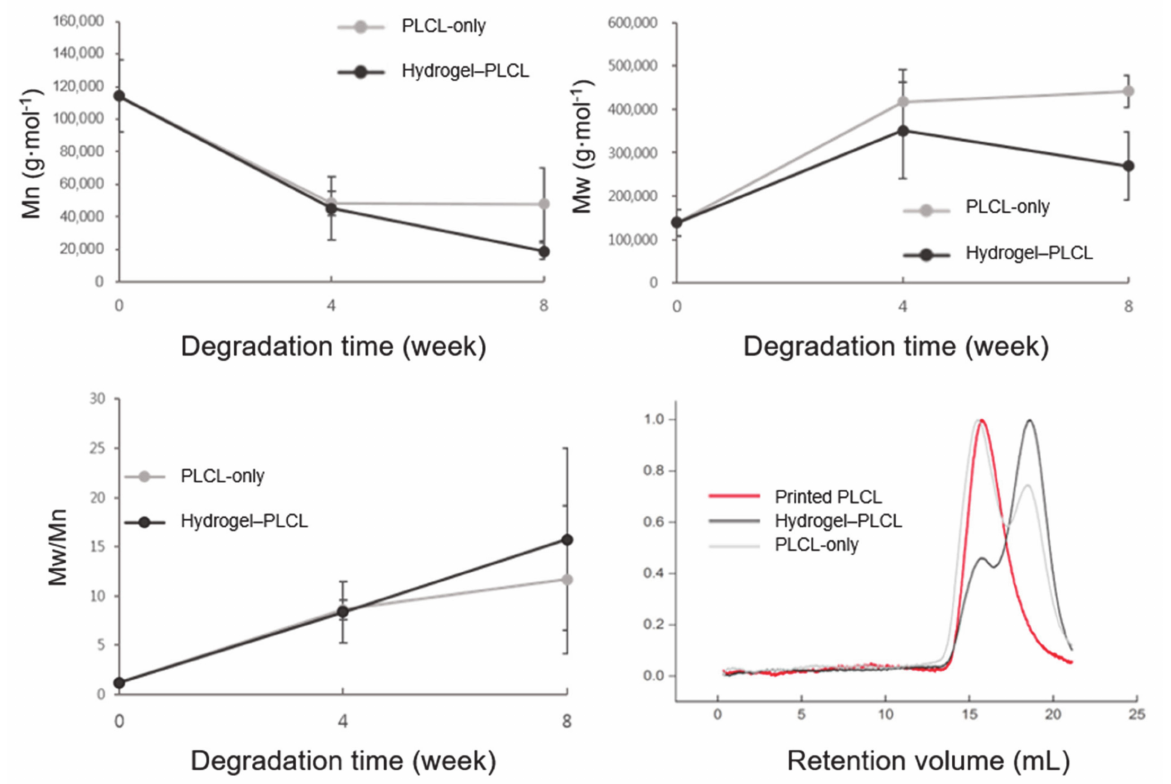
Figure 8. The number (Mn), average molecular weight (Mw), and polydispersity (PDI) value changes of the scaffolds from the in vivo degradation